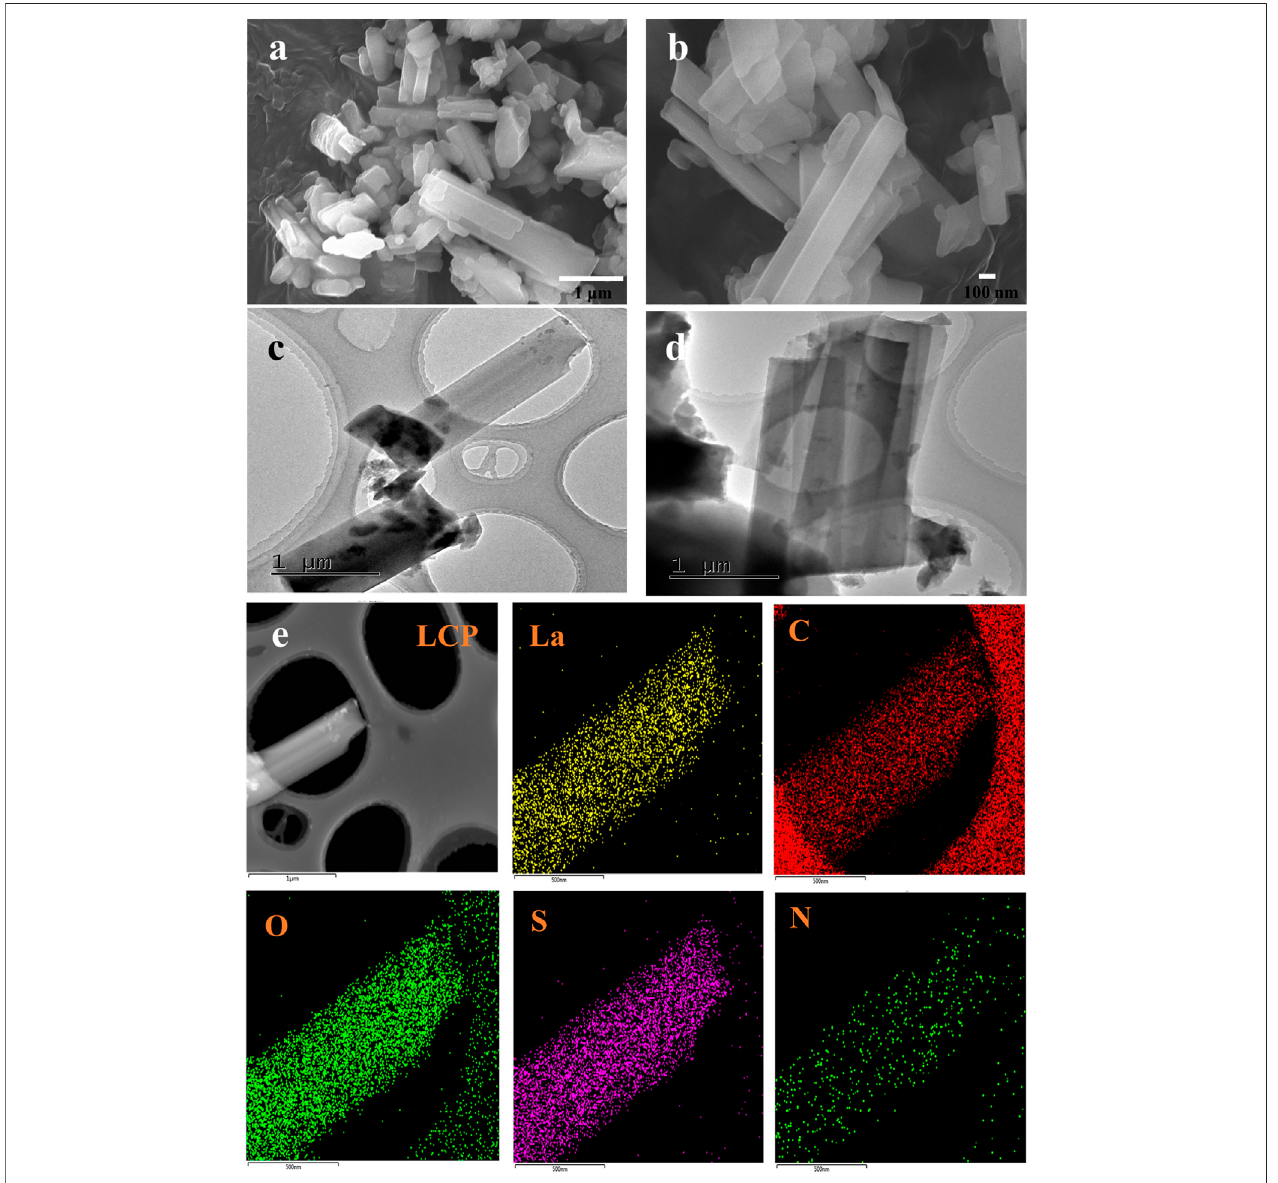
FIGURE 2 | SEM (A,B) and TEM (C,D) images of LCP-1 with different resolutions, (E) STEM elemental mapping of La, C, O, S, and N for